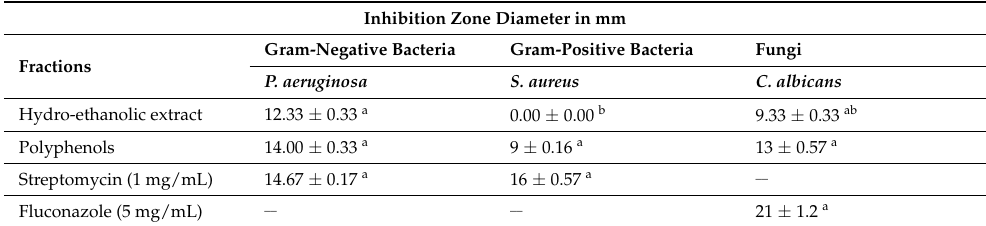
Table 4. Inhibition zone diameters of P. sativum Hoffm. extracts tested against bacterial and fungal